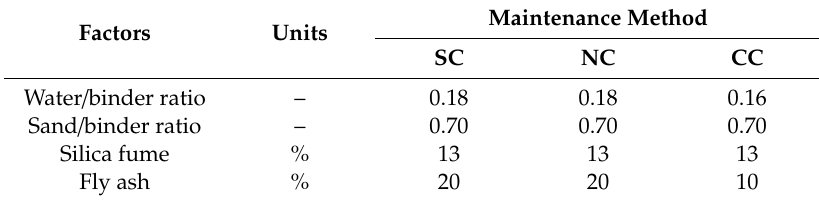
Table 10. Range analysis of the ratio of factors in the optimal